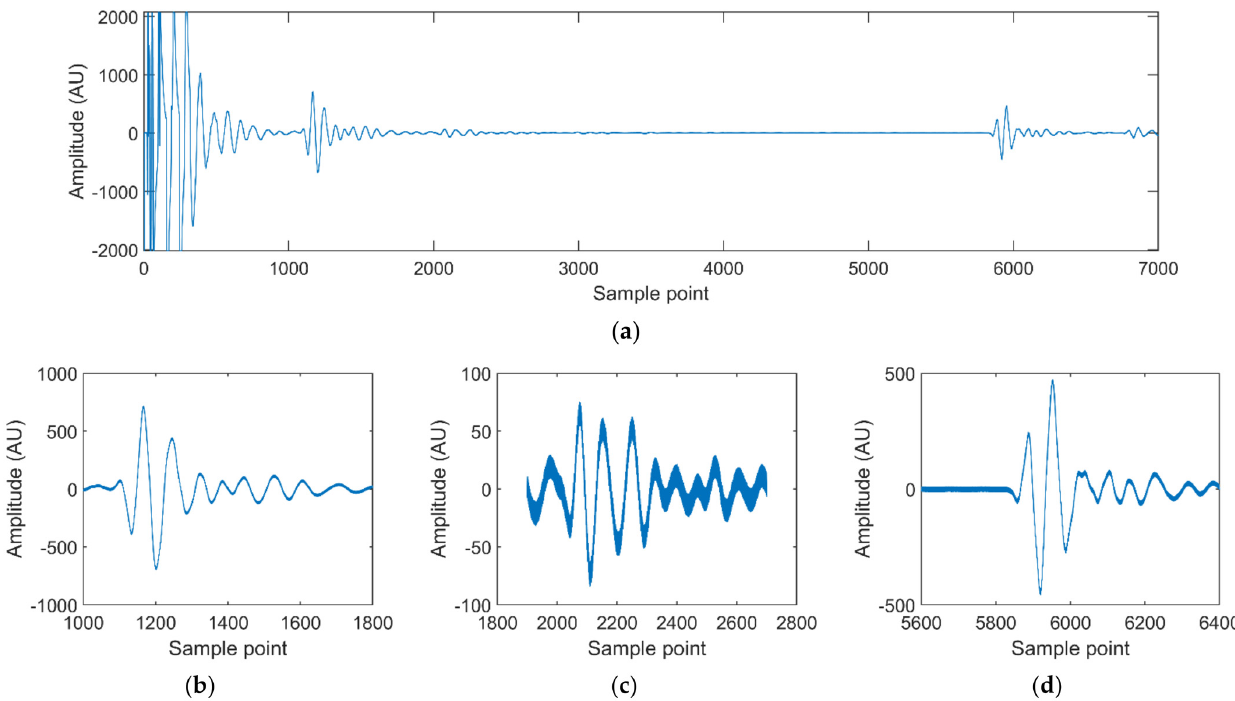
Figure 2. An example US waveform acquired: ( a ) The full waveform received; ( b ) the 1st reflection isolated; ( c ) the 2nd reflection isolated; and ( d ) the 3rd reflection